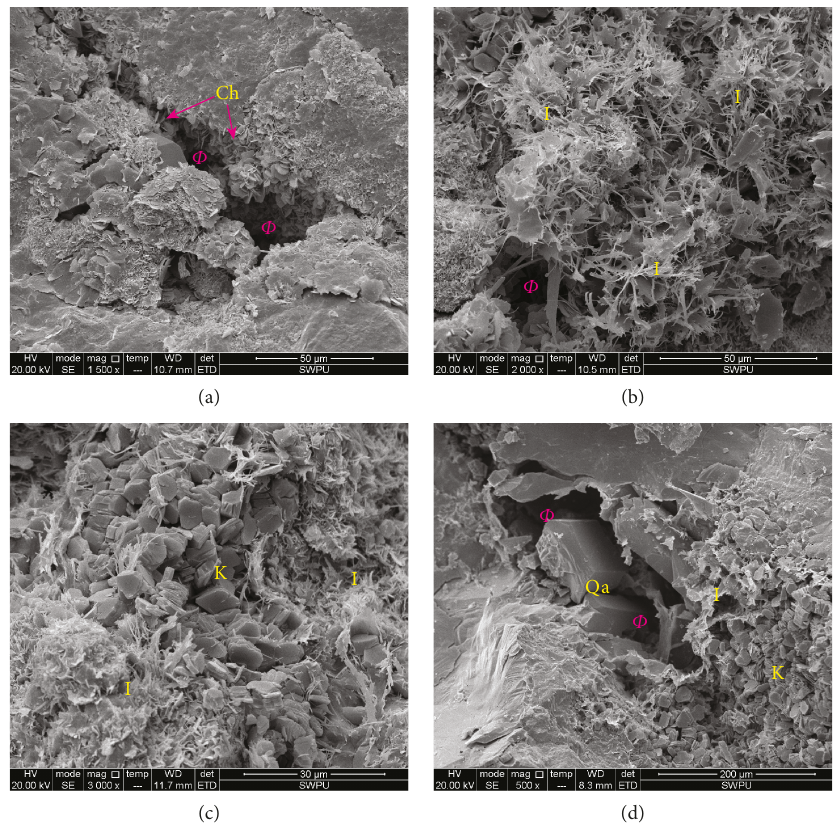
Figure 16: ESEM image showing typical cement habits. (a) Chlorite rim is developed at the margins of mineral grains, and intergranular pores are well preserved, SD24-55, 2799.78m. (b) Silica-like and fl aky illite forms networks or bridge-type cementation, SD24-55, 2954.586m. (c) Feldspar dissolution is associated with kaolinite. Kaolinite intercrystalline pores are developed, and kaolinite illitization can be seen locally, SD24-55, 2976.21m. (d) Feldspar dissolution is associated with kaolinite. Kaolinite intergranular pores are developed, and kaolinite illitization can be seen locally. Authigenic quartz is developed in intergranular pores, SD24-55,